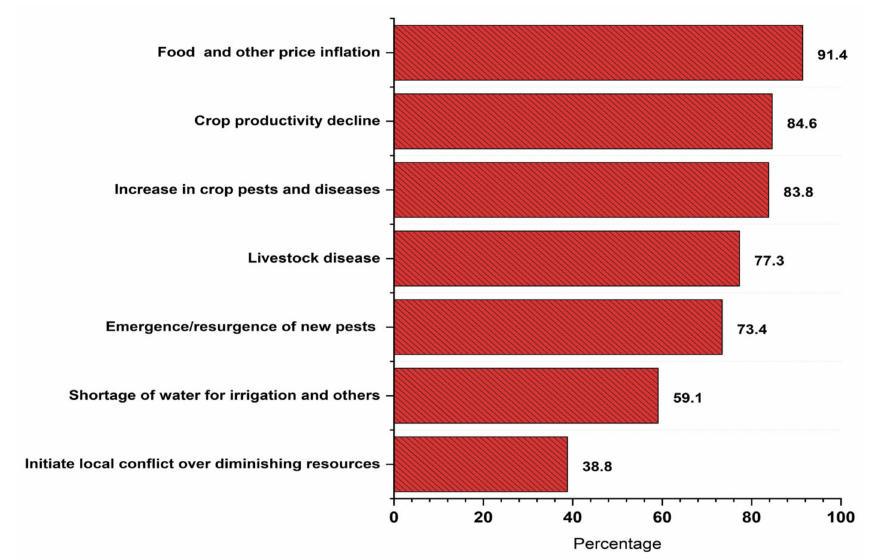
Figure 15. Perceived impacts of climate change, variability, and extreme events